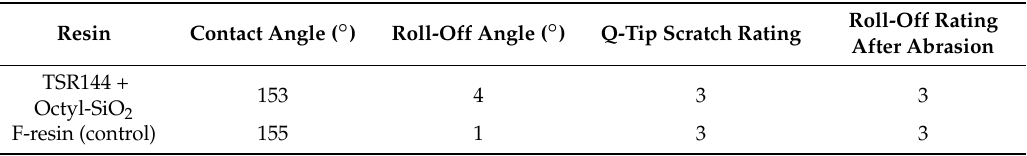
Figure 8. Surface and cross-section SEM images of a coating based on TSR194 and octyl-modified colloidal silica. ( a ) cross-section SEM image; ( b ) surface SEM image. Table 4. Properties of the superhydrophobic coating based on epoxy-modified silicone resin and octyl-functionalized colloidal silica.